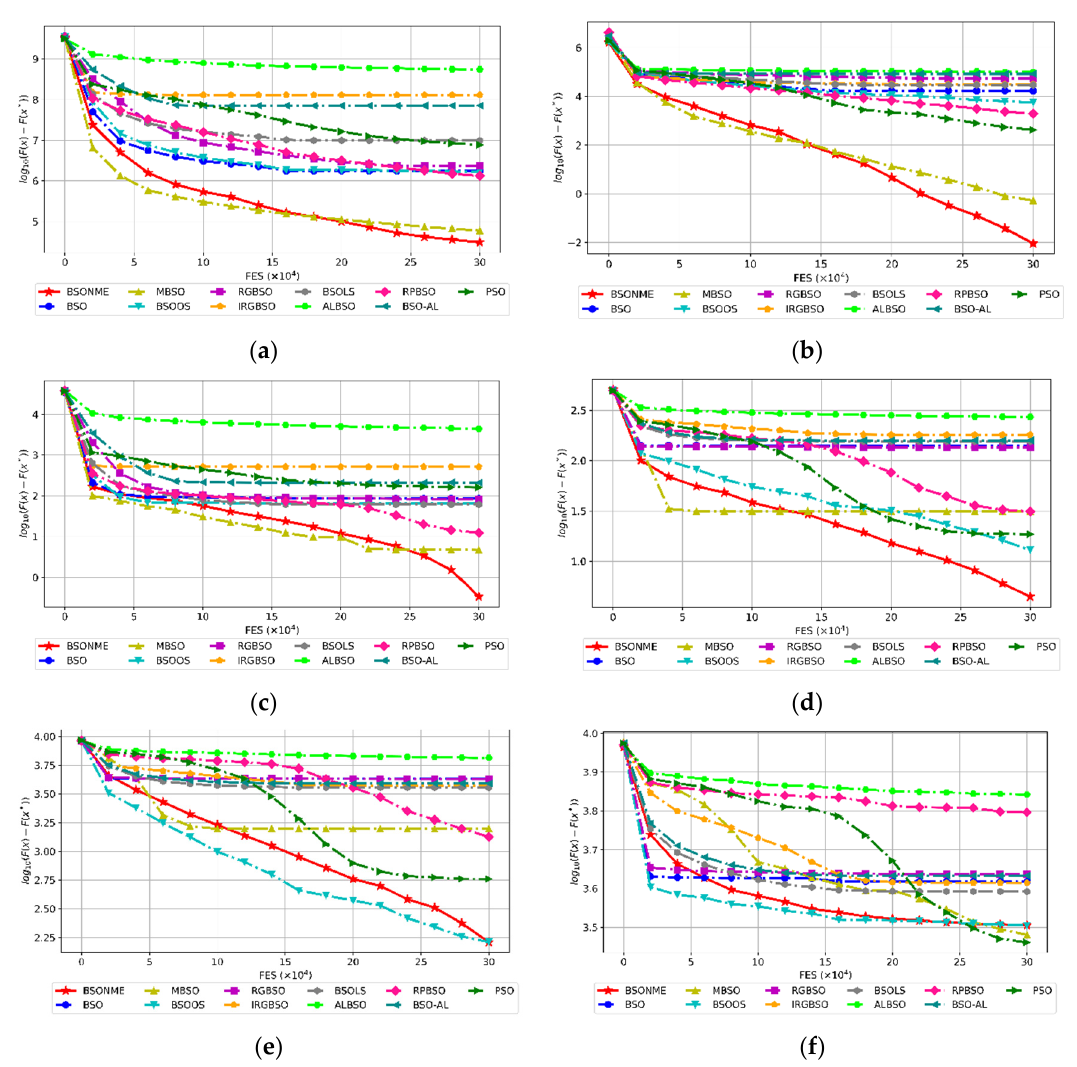
Figure 8. Evolution of the mean values of solution error derived from PSO, BSO, MBSO, BSO-OS, RGBSO, IRGBSO, BSOLS, ALBSO, RPBSO, BSO-AL, and BSONME versus the number of FES on six test problems. ( a ) F 1 ; ( b ) F 3 ; ( c ) F 4 ; ( d ) F 8 ; ( e ) F 10 ; ( f ) F 11 .